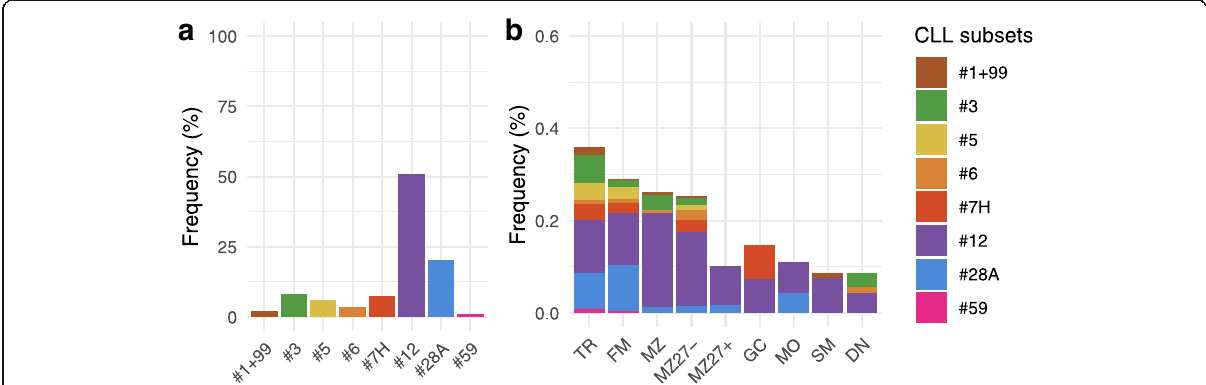
Fig. 1 Relative frequency of different stereotype subsets among the CBS-IG rearrangements of s-BCS. a Frequency of subsets used by CBS-IG rearrangements of B cells considered in bulk. b Relative frequency of the subsets found among the CBS-IG rearrangements expressed by the various s-BCS. Stereotype subsets are marked by different colours as